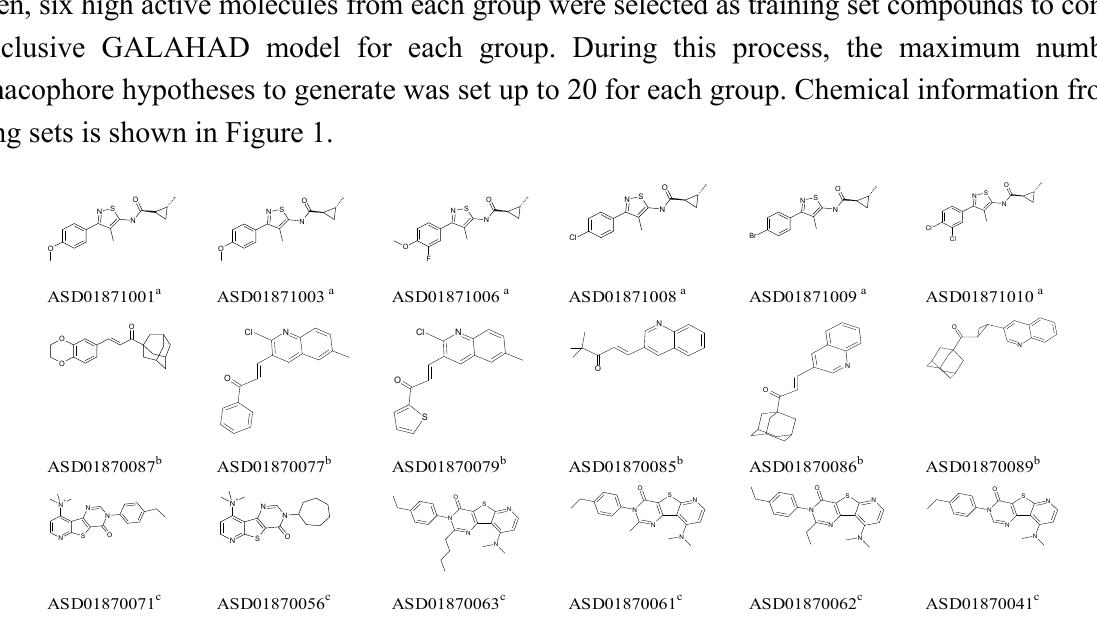
Figure1. Structures of six high active mGluR1 NAMs derived from each group. The superscripts a, b and c represent the corresponding Groups A, B and C. Each six mGluR1 NAMs represented a specific chemical structure type and were defined as the training set to build an exclusive GALAHAD